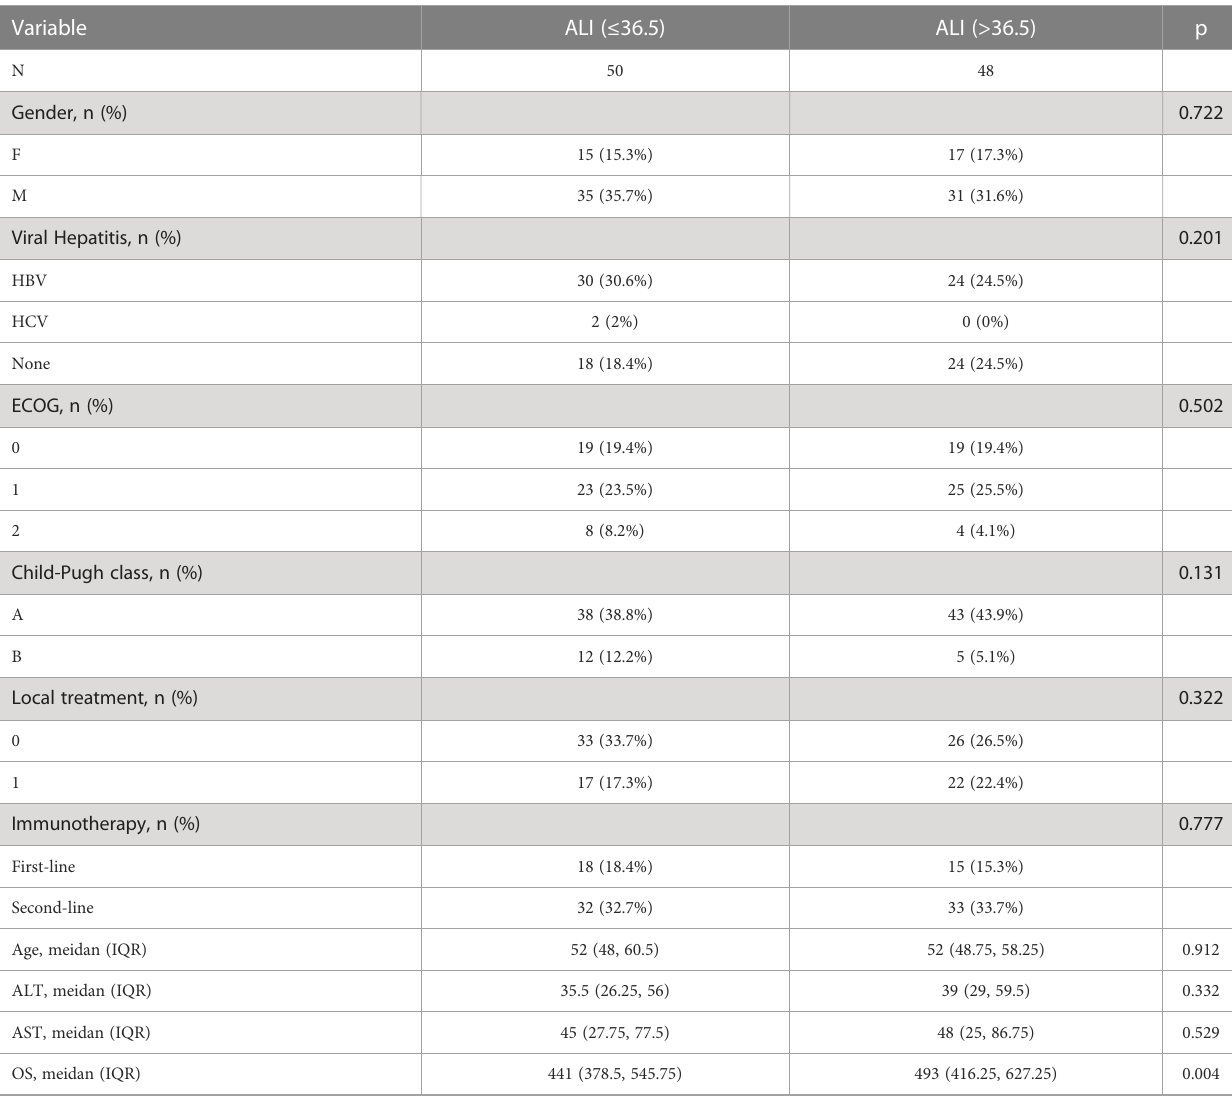
TABLE 2 The correlations between the ALI and the clinicopathological factors.